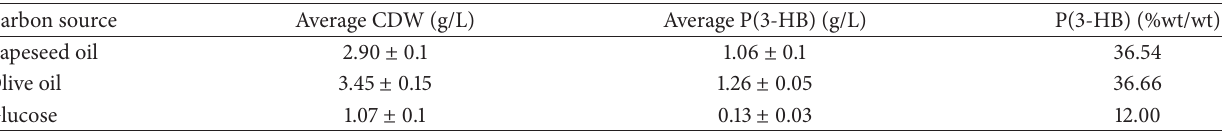
Table 1: Average cell dry weight (CDW) and PHB production by R. eutropha NCMBI 14402 grown in BSM at 30 ∘ C and 150rpm for 48 hours with olive oil, rapeseed oil, and glucose used as carbon sources.